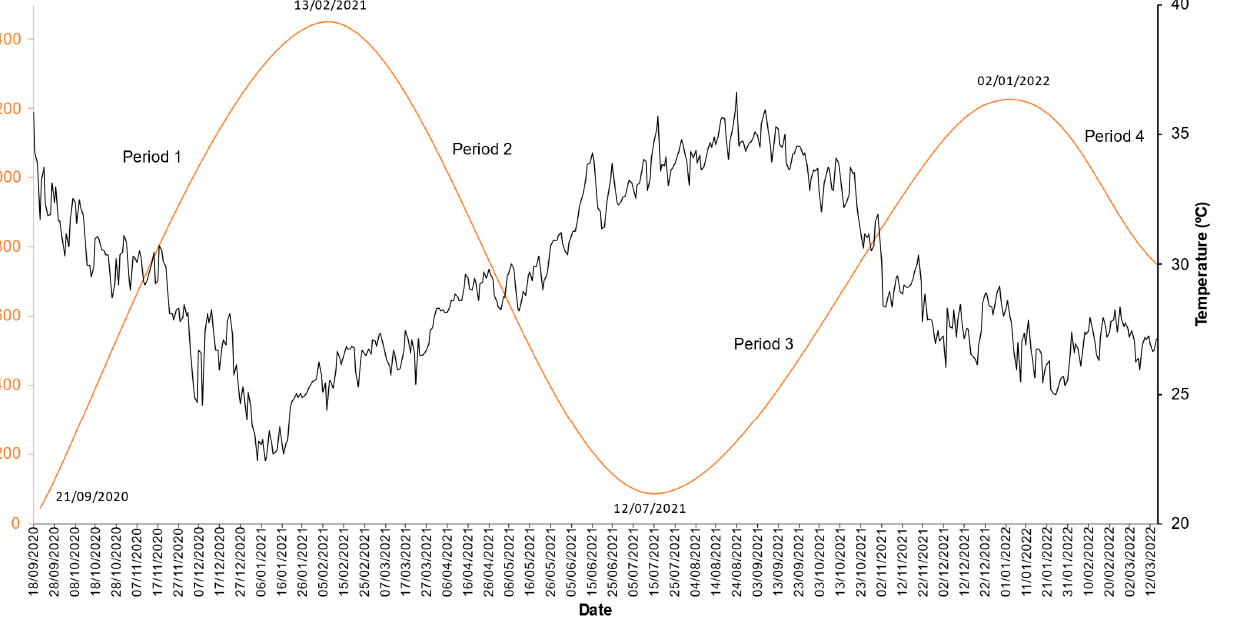
Figure 3. Superimposition showing the evolution of the temperature recorded in the compartment under analysis in this study (black line) and the sinusoidal representative for the evolution of the indoor Rn concentration (orange line) during the period in which the monitoring took place.